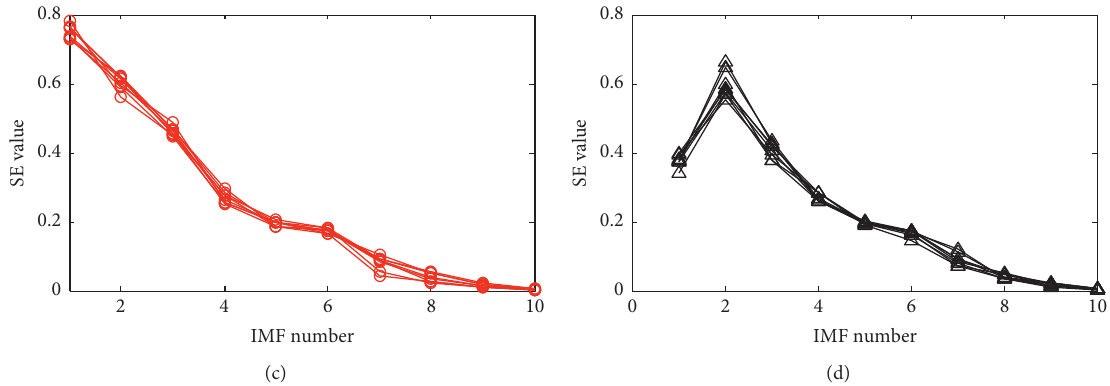
Figure 7: The distribution patterns of SE on different IMF components. (a) The average SE values of each IMF component of different fault conditions. (b) 8 samples of ball fault. (c) 8 samples of inner race fault. (d) 8 samples of outer race fault.